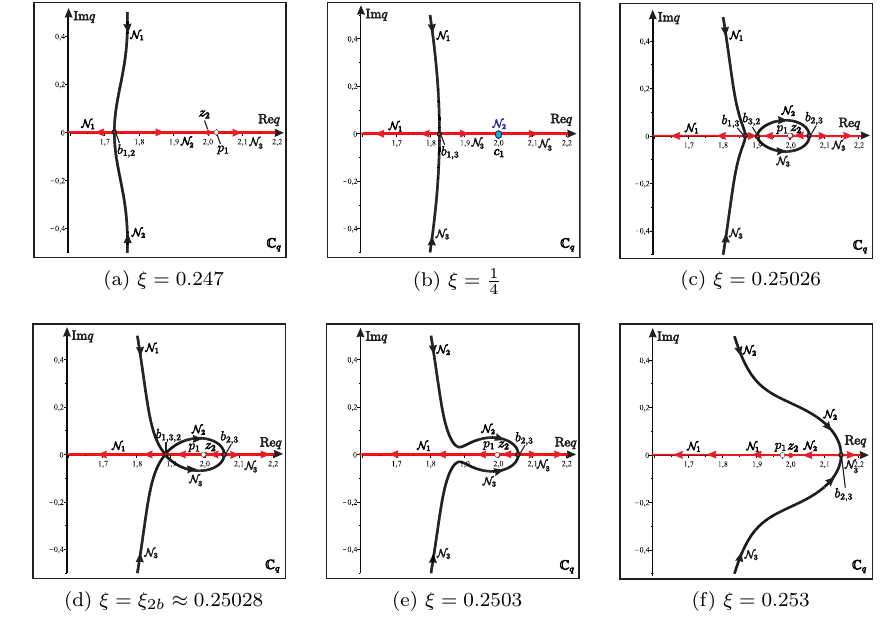
Figure 7. Spectrum Curves for various parameter ξ values,